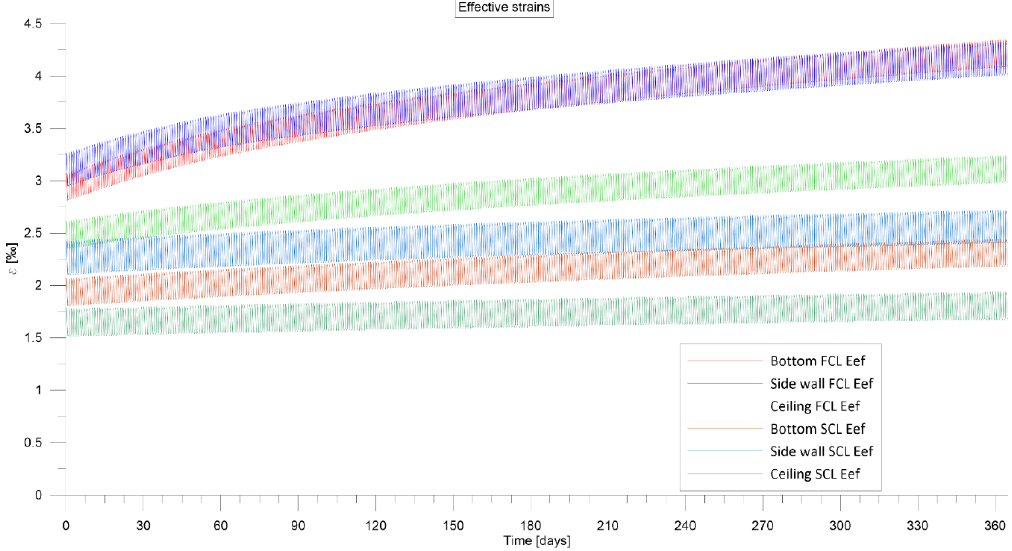
Figure 9. Comparison of the effective strains obtained for the slow-(SCL) and fast-creep law (FCL) models, with temperature changes in the rock mass for the considered elements on the cavern contour.